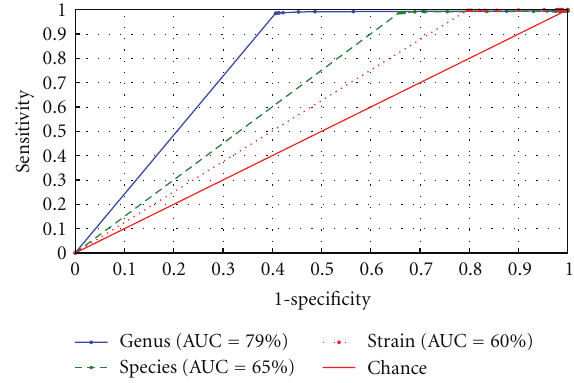
Figure 2: The ability of BLAST to discern the correct strain genome (in red-dashed), species genome (in green-dash) and the correct genus label (in blue) for the known 63, 500 (100 randomly selected reads from each of 635 known genomes) plus unknown 10, 200 (100 randomly selected reads from 102 novel genomes) 25bp reads. The ROC curves compare BLAST’s bit scores against a varying threshold. The plot demonstrates that BLAST predicts most “known” genomes correctly at the optimal operating point, but incorrectly detects “unknown” genomes. For the strain detection, the area-under-the-curve is 60.1% with the best threshold yielding a sensitivity of 99.8% and specificity of 20.4%. For the species-level detection, the AUC is 65% with 99.1% sensitivity and a specificity of 34.7%. For the genus detection, the area-under-the-curve is 78.9% with the best threshold yielding a sensitivity of 98.6% and specificity of 59.3%. The red line represents the 50% chance line.